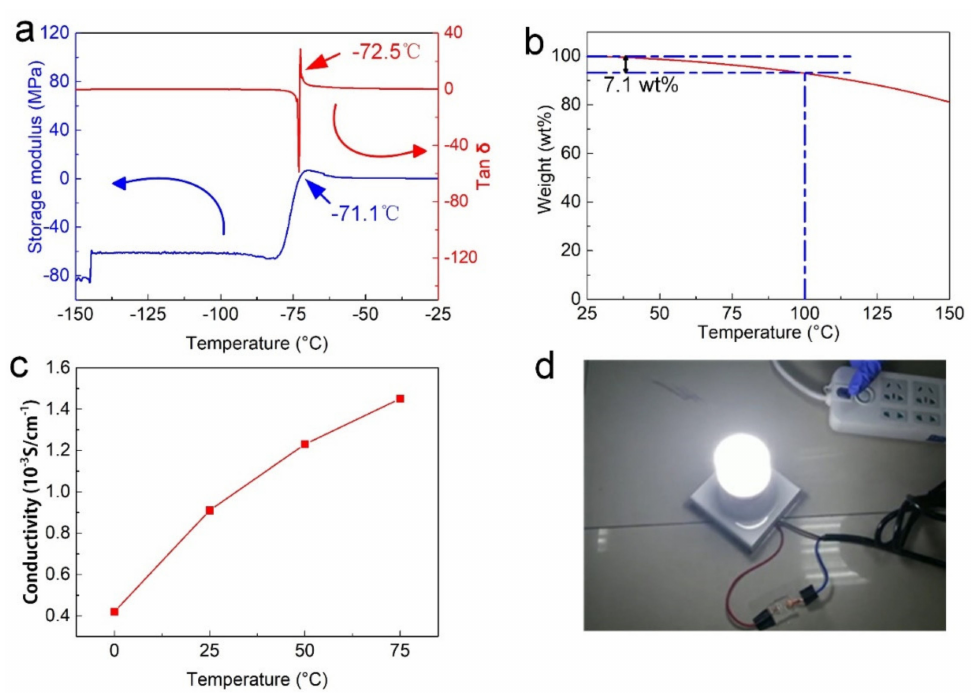
Figure 3. Thermal properties of OICs: ( a ) dynamic thermomechanical analysis and ( b ) thermogravi- metric analysis. ( c ) Ionic conductivity of OICs in the temperature range of 0 to 75 ◦ C, ( d ) lighting up a bulb using OICs instead of